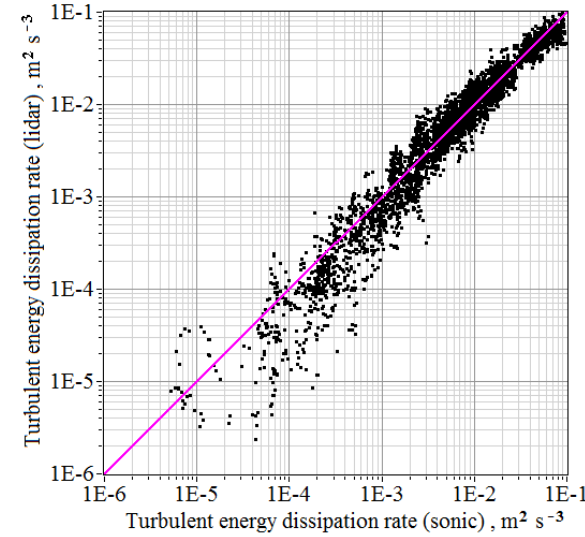
Figure 5. Comparison of estimates of the turbulence energy dissipa- tion rate obtained from data of simultaneous measurements by the sonic anemometer and the Stream Line lidar. Time series of these estimates are shown in Fig.